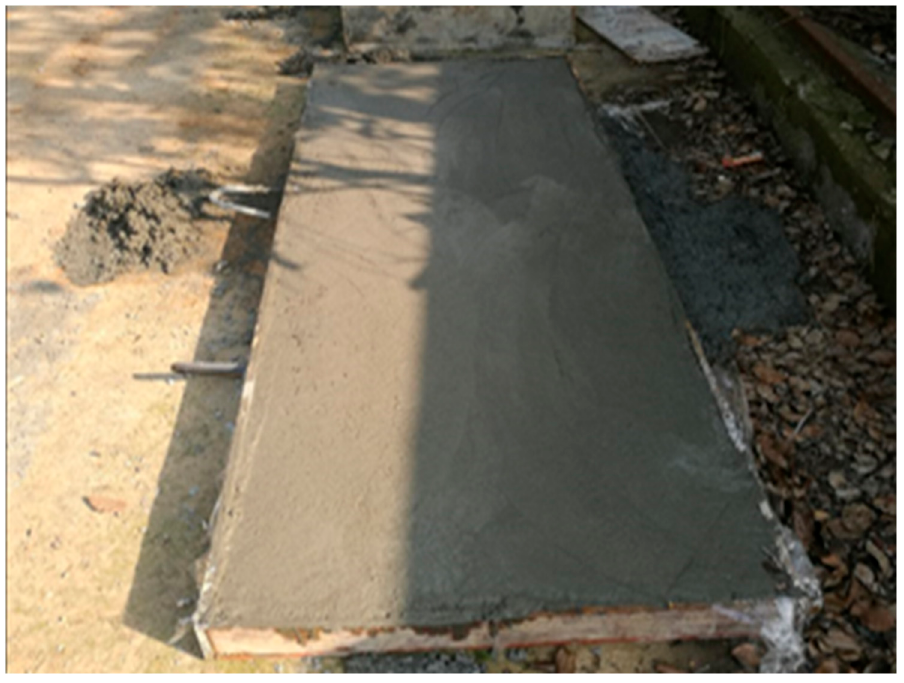
Figure 4. Mold making and steel binding.